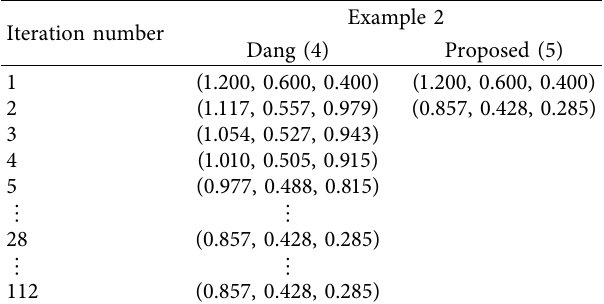
Table 3: Comparative sequences of the Dang method (4) and proposed method (5) for the numerical experiment of Example 2 with three decimal places.